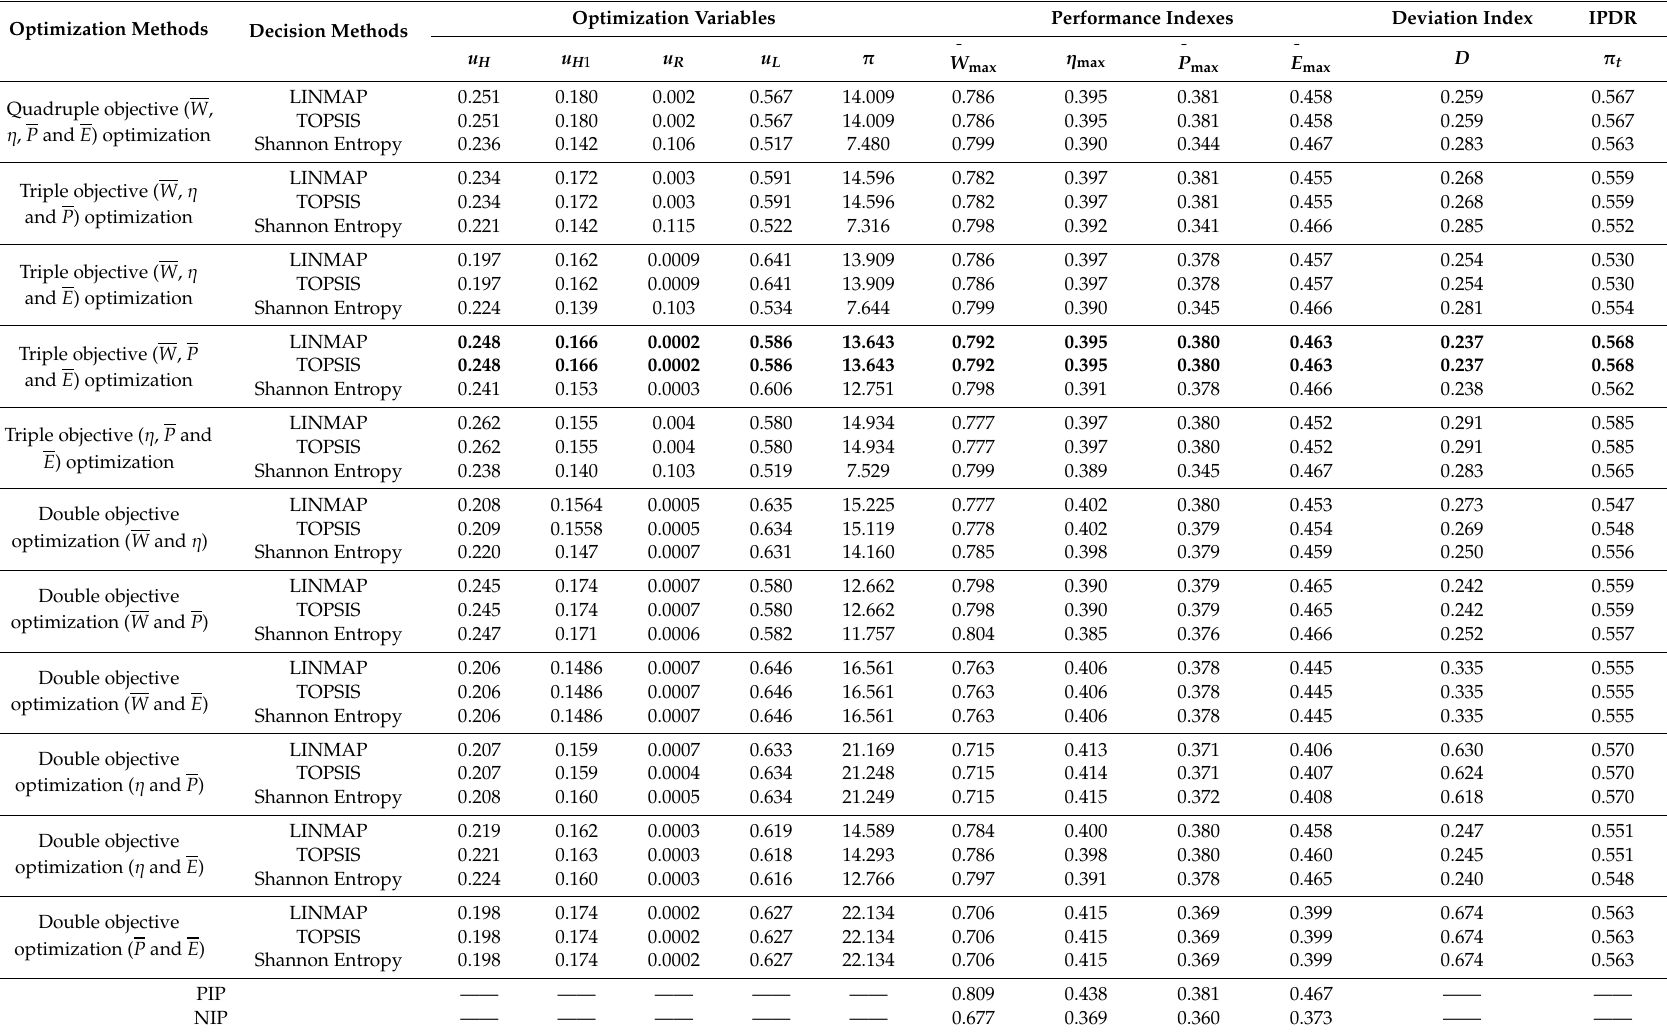
Table 1. Comparison of double, triple and quadruple objective optimization’s